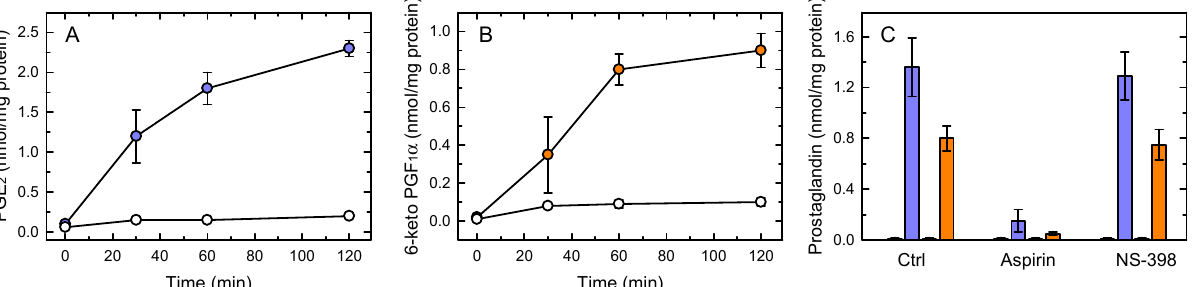
Figure 1. PG production by zymosan-stimulated macrophages. The cells were left untreated (open symbols) or treated with 1 mg/mL zymosan (colored symbols) for the indicated times, and the levels of PGE 2 ( A ) and 6-keto-PGF 1 α ( B ) in the supernatants were measured by LC/MS. ( C ) Effect of COX inhibitors on PG production. Aspirin (20 µM), NS-398 (5 µM) or neither (Ctrl) were present at the time the cells were stimulated with zymosan. After 1 h, PGE 6-keto-PGF 1 α (orange bars) were measured by LC/MS. The small bars to the left of the colored bars represent the basal PG production in the absence of stimulus. The results, given as nmol PG per mg of total cell protein, are shown as means ± standard error (n =